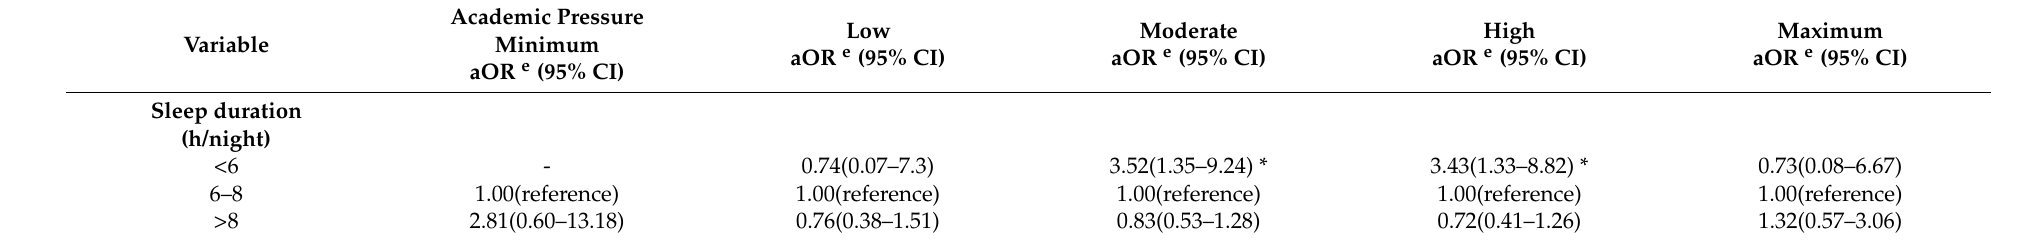
Table 3. Association between sleep duration and depressive symptoms stratified by academic